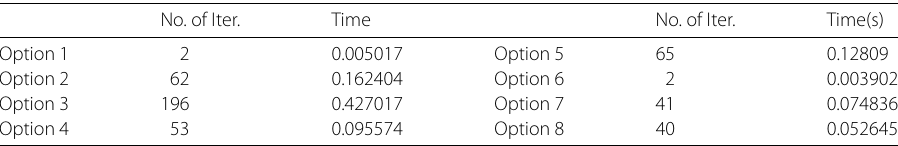
Table 1 Algorithm 3.1 in this paper under diverse options of x 0 and x 1 No. of Iter.